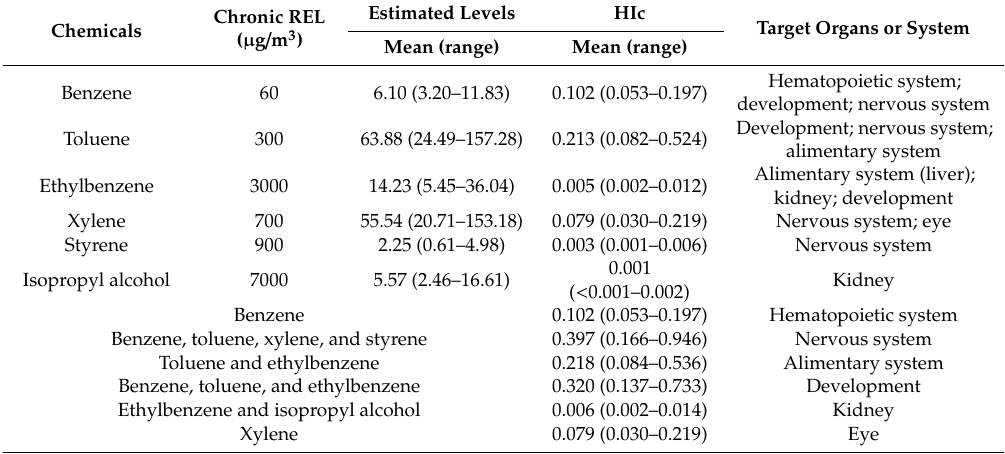
Table 4. Estimated levels ( µ g / m 3 ) and hazard index of chronic health e ff ects (HIc) for residents exposed to six VOCs in the vicinity of an optoelectronics industrial park.